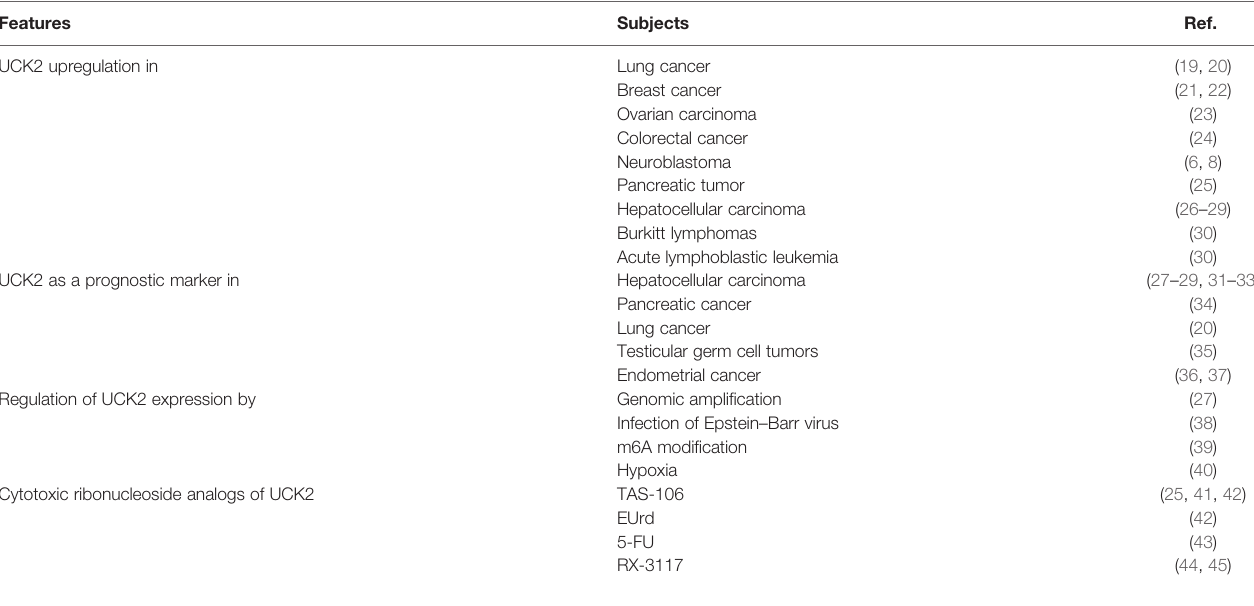
TABLE 1 | UCK2 in tumor development and chemotherapy.